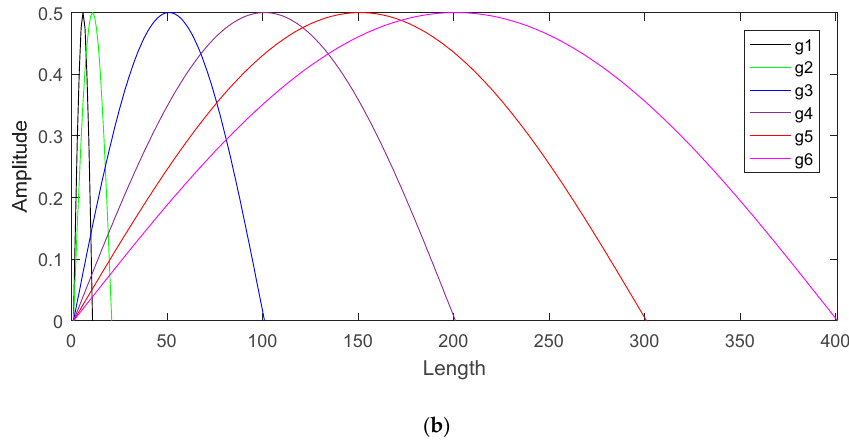
Figure 1. ( a ) The results of processing a signal using the mathematical morphological filtering (MMF) with different structural elements; ( b ) the corresponding structural elements of the results in Figure 1a.